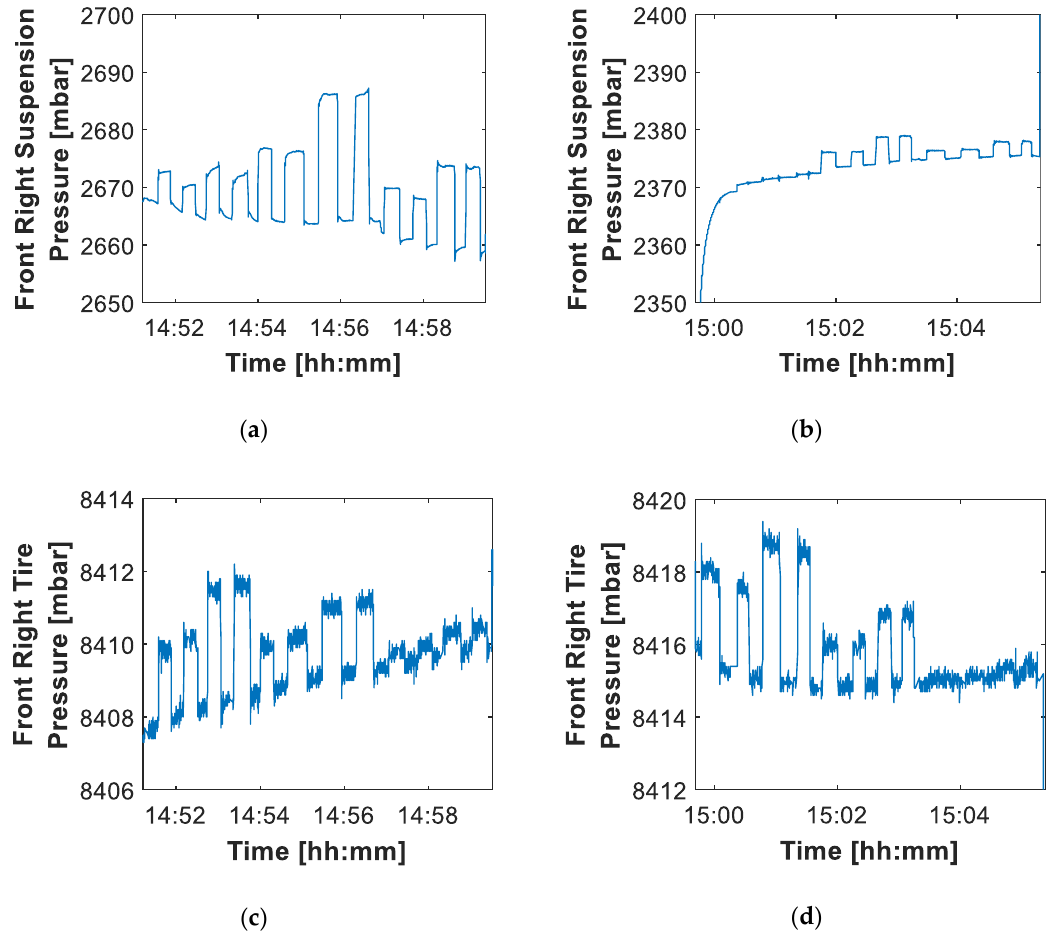
Figure 12. Influence of lowering on suspension and tire pressure. ( a ) Front Right Suspension, leveled. ( b ) Front Right Suspension, lowered. ( c ) Front Right Tire, leveled. ( d ) Front Right Tire, lowered.